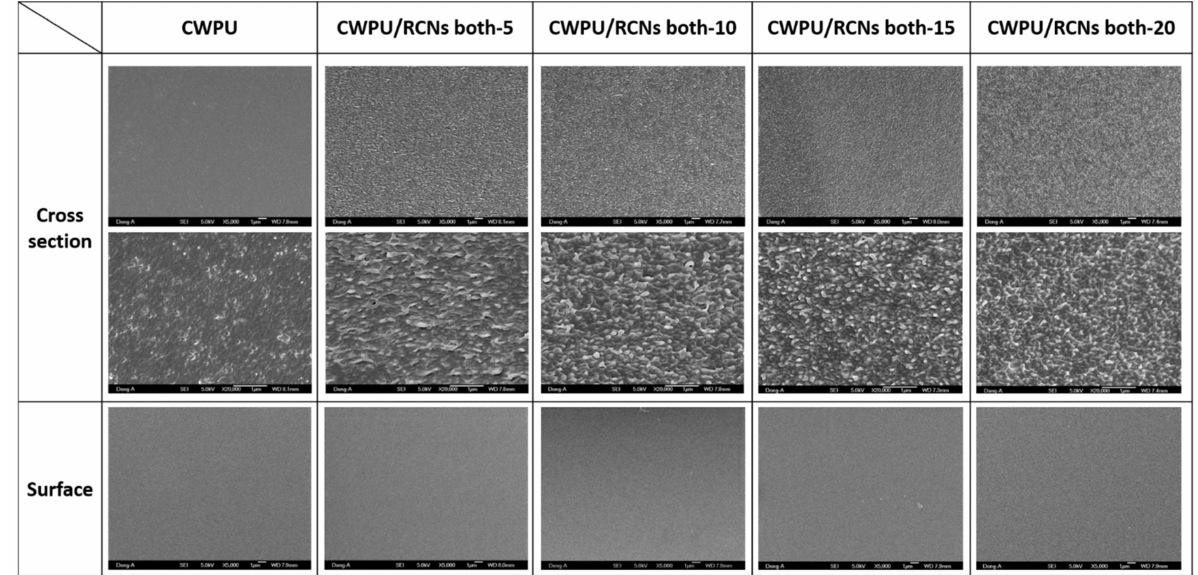
Figure 7. Surface and cross-section scanning electron microscopy (SEM) images of the CWPU and CWPU/RCNs nanocomposite films according to RCNs